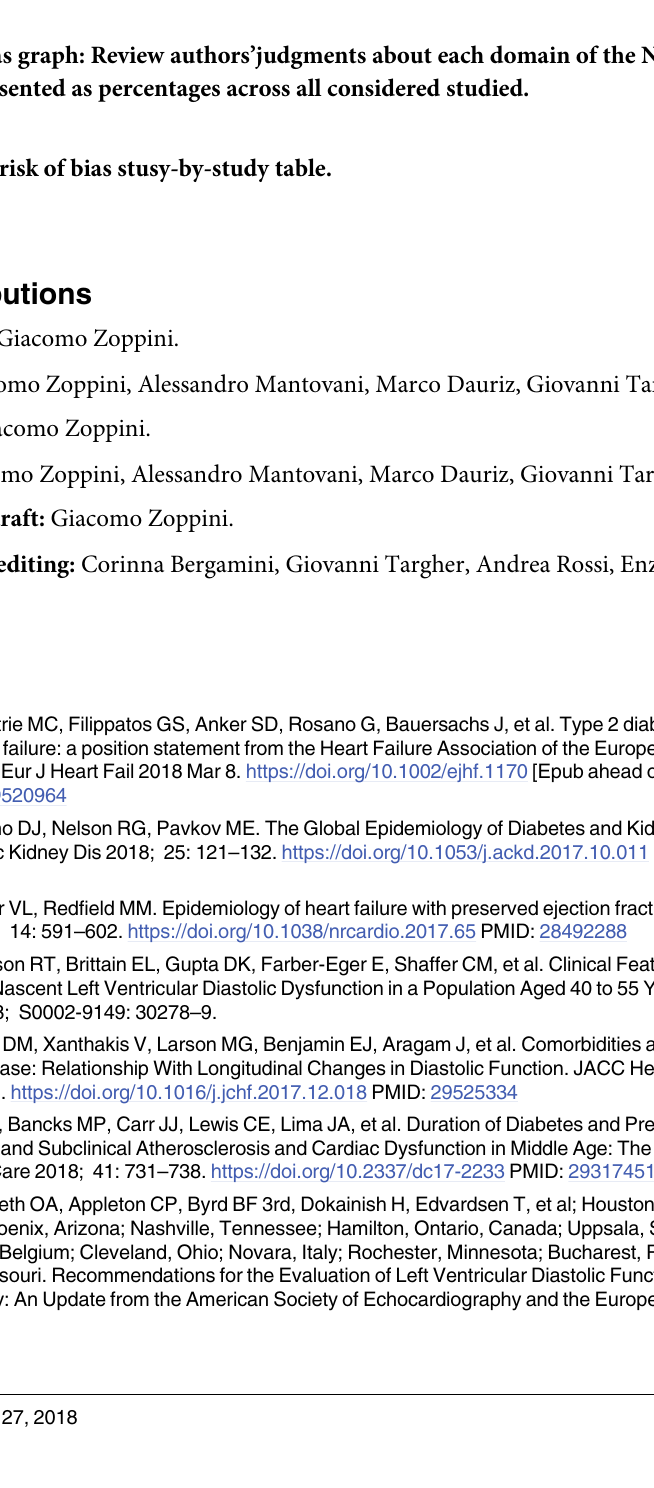
S1 Table. PRISMA checklist. S2 Table. Supplementary. Subgroups/Sensitivity analyses of the overall effect of studies with � 45 and > 45 participants; studies with NOS > 6 and � 6 score. S3 Table. Newcastle-Ottawa quality assessment scale (NOS). S4 Table. Risk of bias graph: Review authors’judgments about each domain of the Newcas- tle-Ottawa scale presented as percentages across all considered studied. S5 Table. Cochrane risk of bias stusy-by-study